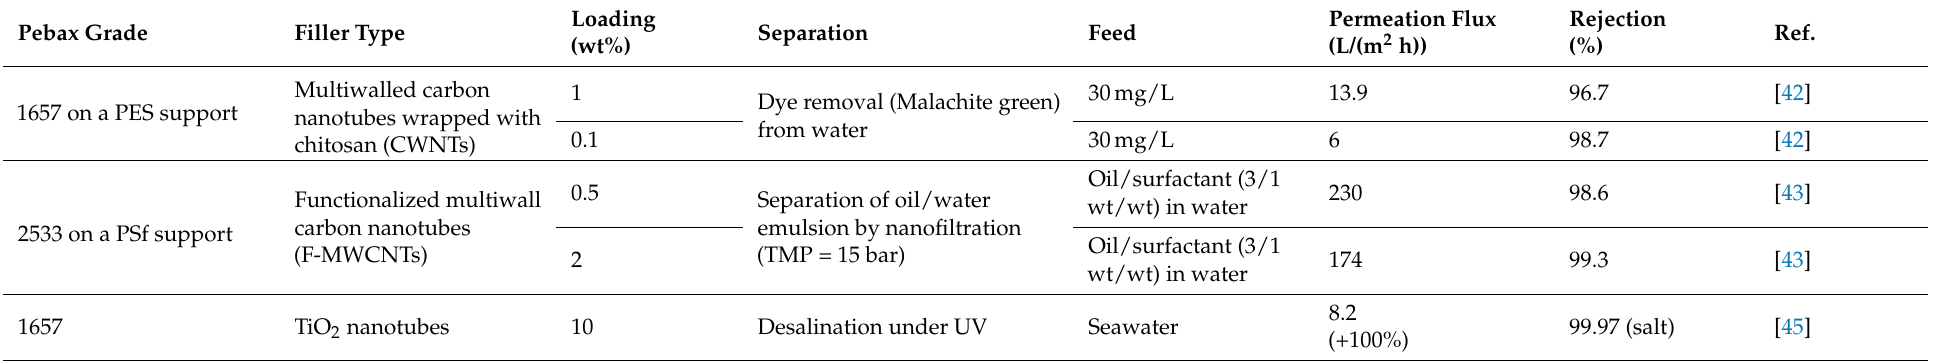
Table 9. Performance of Pebax-based MMMs for water